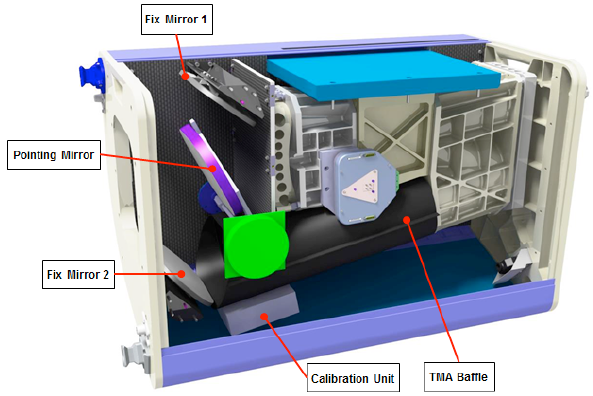
Figure 2. Design of the DESIS Instrument (© DLR-OS) The optical design of the Instrument is based on the Offner-type grating spectrometer, widely used in hyperspectral imaging. The telescope is designed as a Three Mirror Anastigmat (TMA) with 320 mm effective focal length. The Ground Sampling Distance (GSD) at nadir is about 30 m for an ISS flying altitude of 400 km (reference value), resulting in a swath of about 30 km (1024 spatial pixels in the across-track direction). The shutter mechanism is electronically realized as a Rolling Shutter (RS) what translates into different start and stop integration times for each band while keeping the same total integration time among bands. A key advantage of the RS mode is that it allows higher frame acquisition rates than the Global Shutter (GS) mode. Table 1 summarizes the main design parameters of the DESIS Instrument.